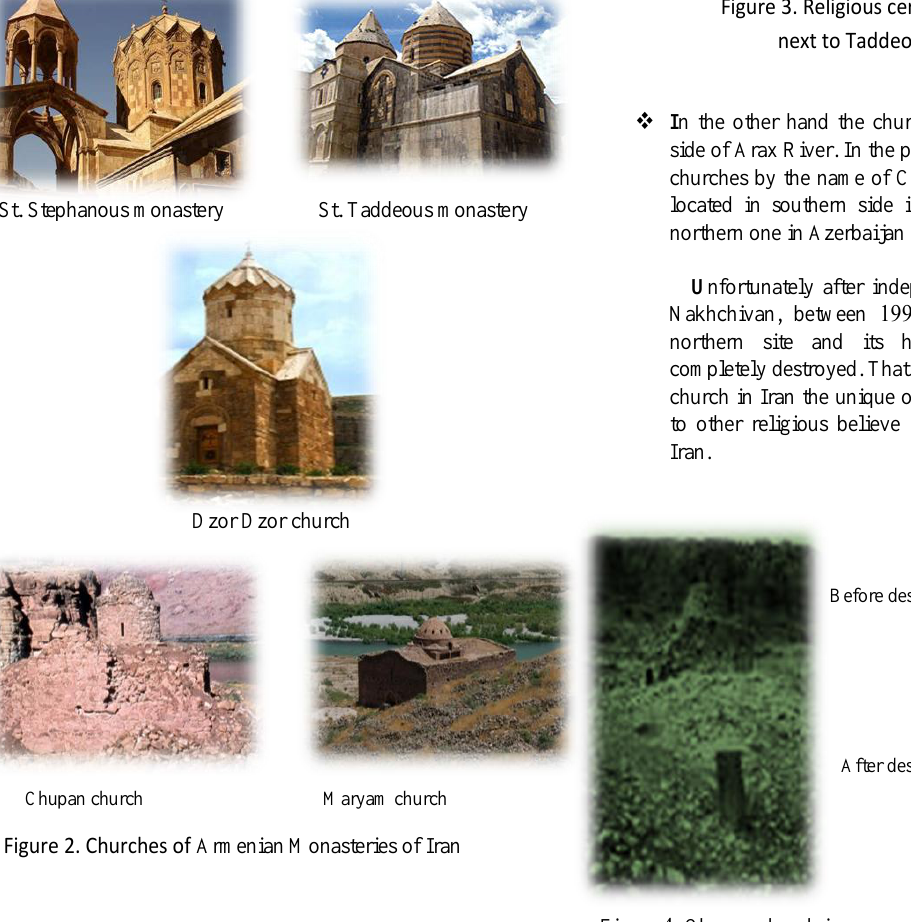
Figure 4. Chupan church in Republic of Nakhjavan.